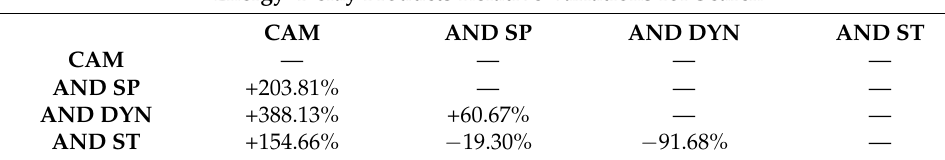
Table 6. Percentage differences in the search energy-delay product among the arrays. Each value corresponds to the increase, expressed in percentage, in the energy-delay product of the memory on the corresponding row with respect to the one of the memory on the corresponding column. The data are extracted from Table